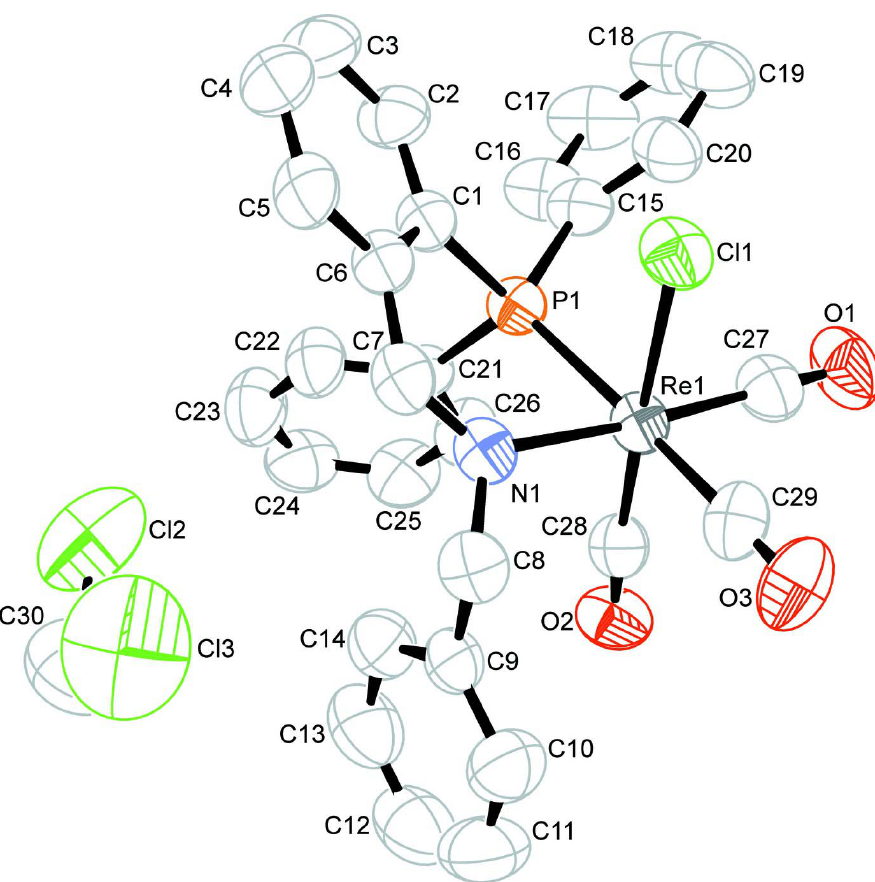
Figure 1 View of the title compound with the atom numbering scheme. H-atoms have been omitted for clarity. Displacement ellipsoids for non-H atoms are drawn at the 50% probability